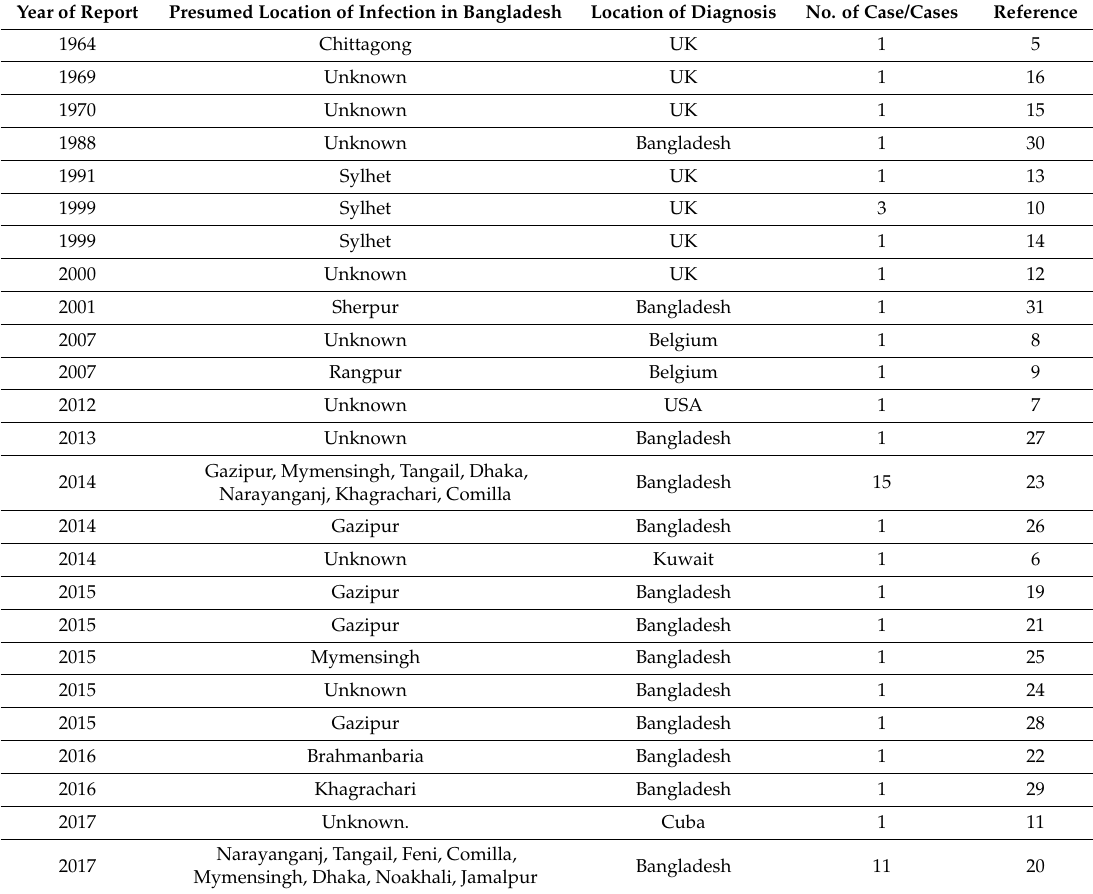
Table 1. Reports of all culture-confirmed melioidosis cases from Bangladesh.